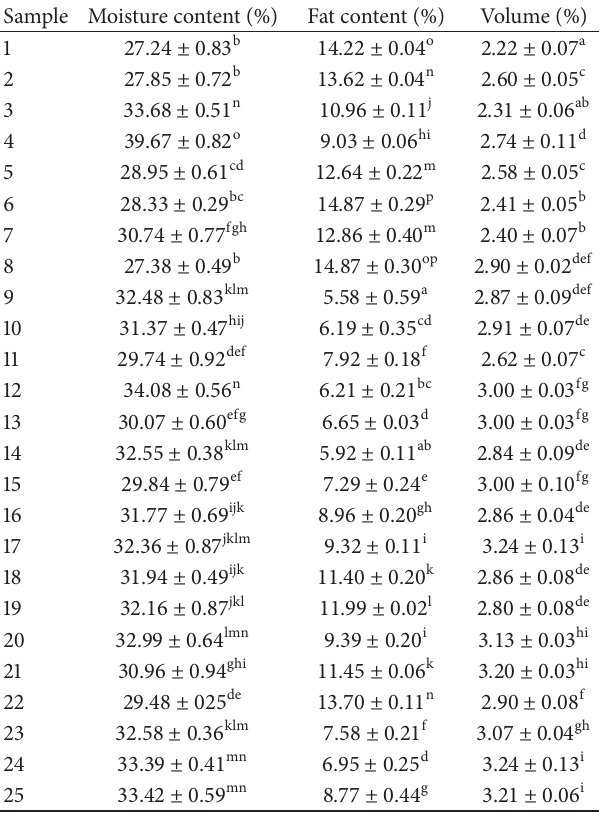
Table 2: Physicochemical results of all the fried fritters samples. Sample Moisture content (%)